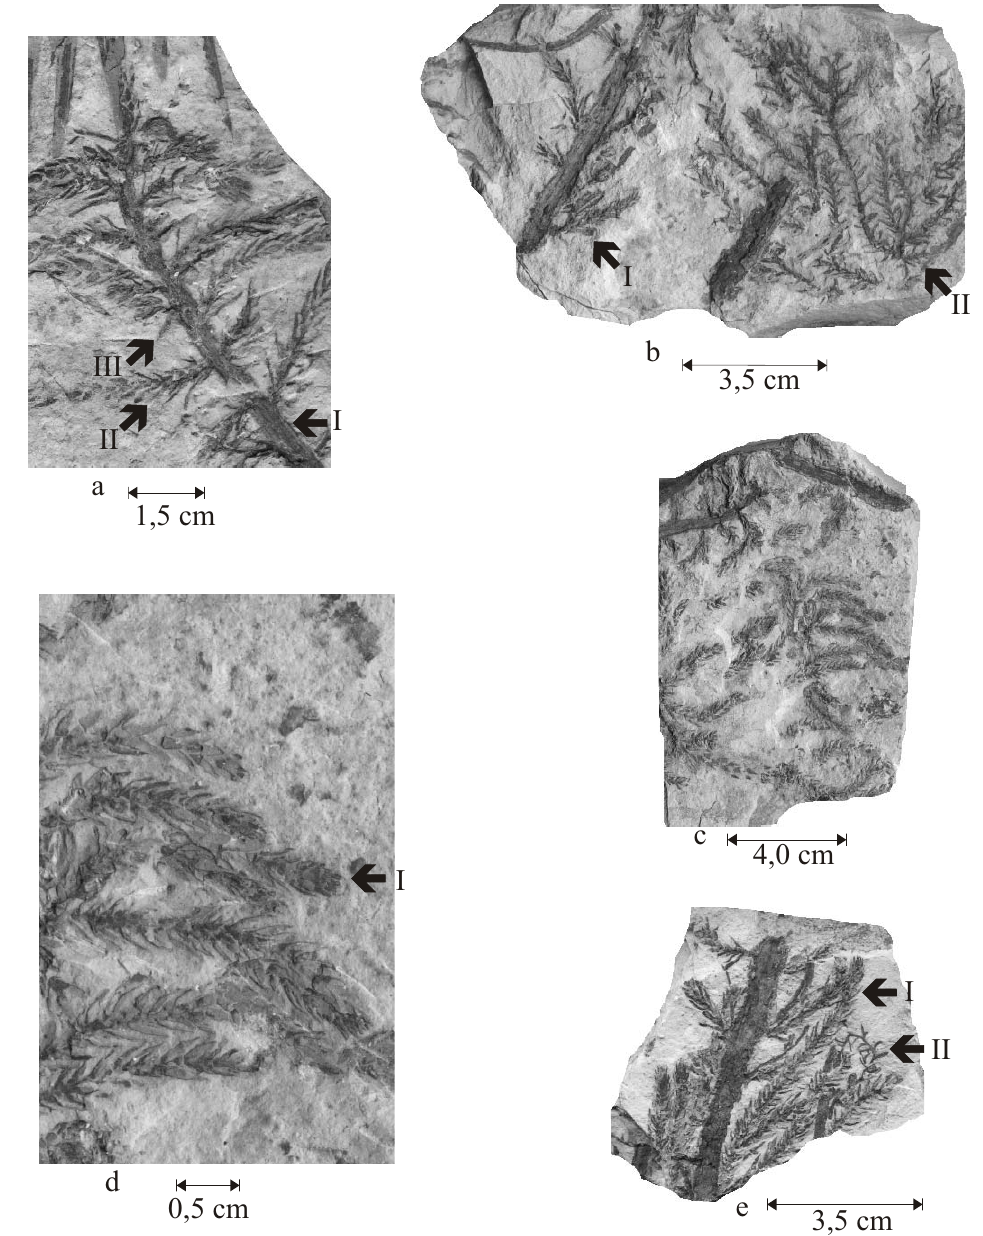
Fig. 3 – Coricladus quiteriensis sp. nov. vegetative branches from Quitéria outcrop: (a) medial portion of a branch, demonstrating the leafless principal branch (I), the distribution of first order branches (II) and of the acicular leaves at its insertion (III) – PbU 226; (b) branches covered with leaves disposed in overlapping spirals, what provides some branches with a more dense coverage (I), but not so dense on others (II) – PbU 417; (c) second and third order branches with the same leaf coverage pattern observed in first order branches – PbU 191; (d) apical portion of the branches, demonstrating a globular densification of the leaves (I), which clearly characterize apical sprouts – PbU 191; (e) vegetative (I) and reproductive (II) branches coming from the leafless principal branch, presenting scarce leaves and cones – PbU 074